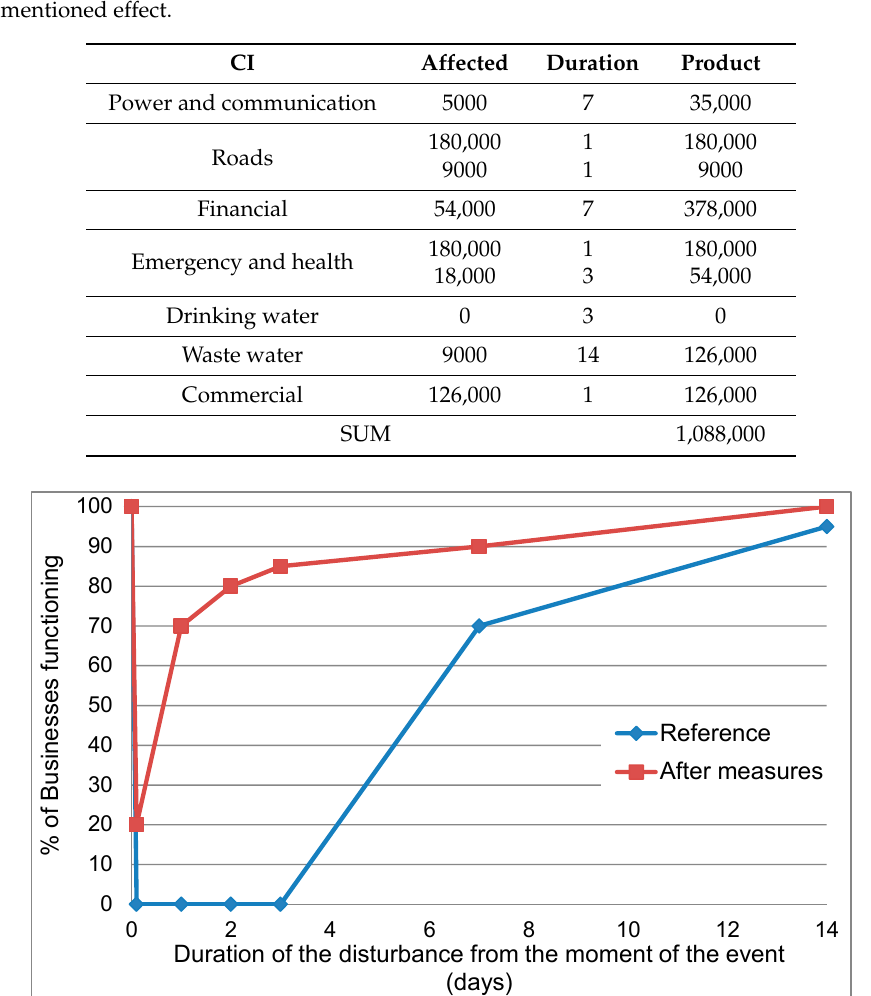
Figure 10. Businesses disruption before and after implementing measures.